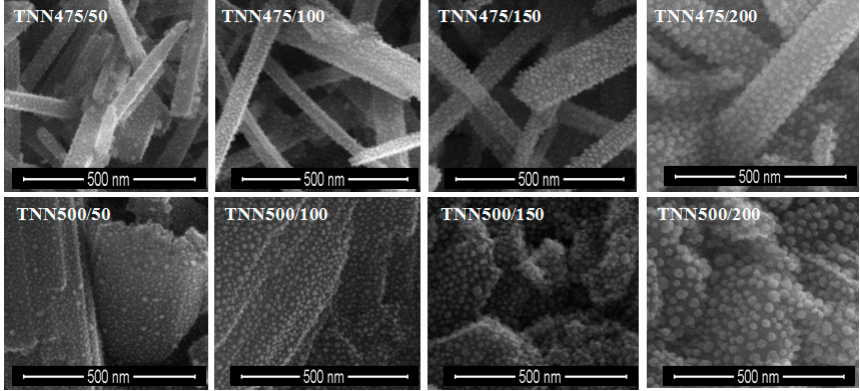
Figure 2. SEM images of TNN/Ag nanocomposite samples consisting of TNN layers prepared at 475 and 500 °C, and enriched with silver grains during 50, 100, 150, 200 ALD cycles.